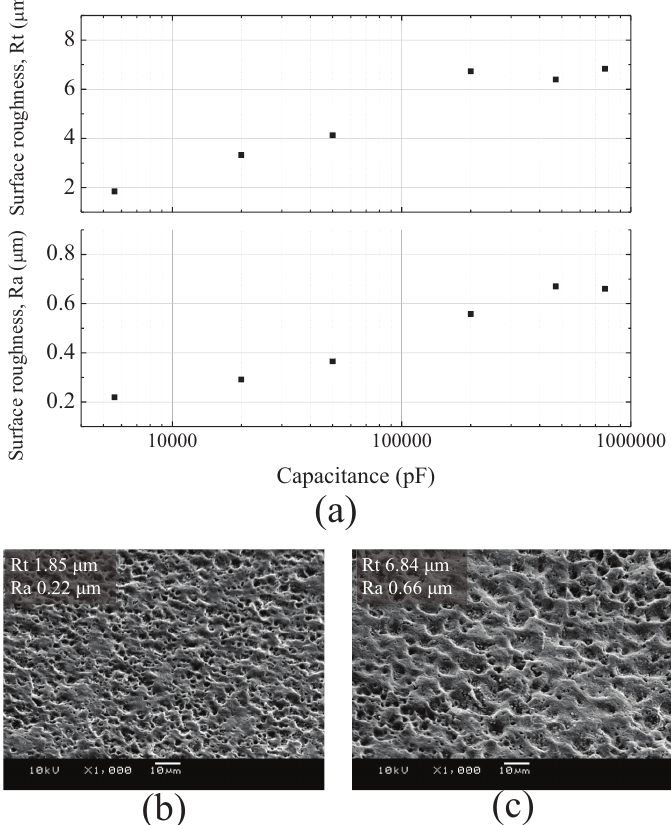
Figure 6. ( a ) Surface roughnesses according to different capacitances, and SEM images of surfaces for ( b ) 5600 pF and ( c ) 770,000 pF.